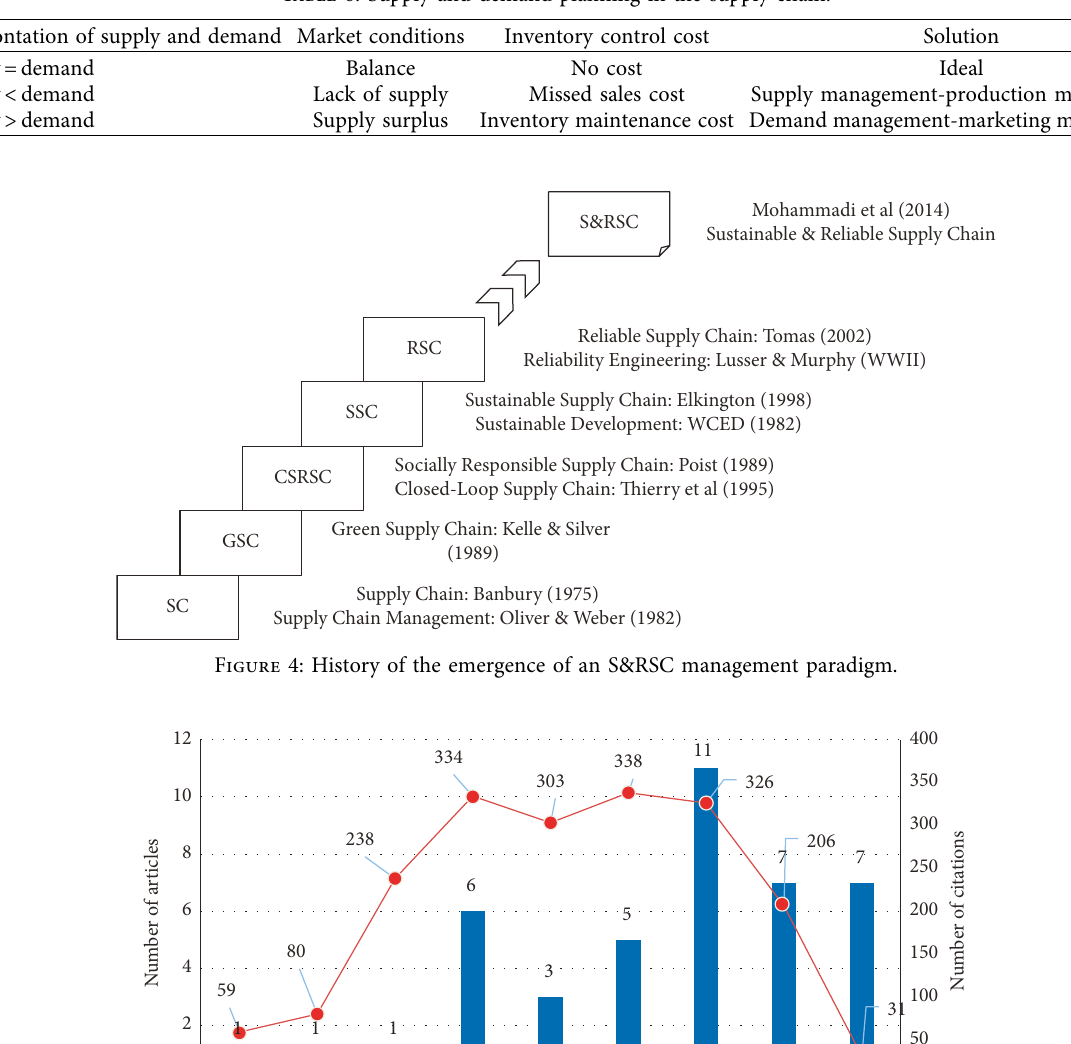
Table 6: Supply and demand planning in the supply chain.